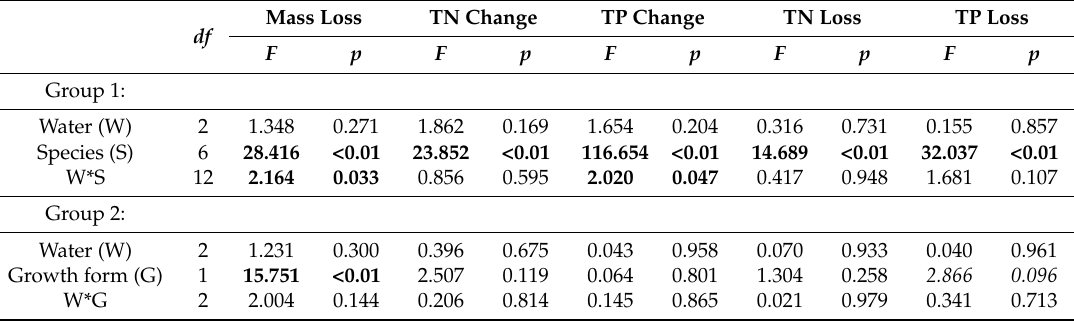
Table 1. ANOVAs for effects of water substrates (W) and plant species (S) or growth form (G) on the litter mass loss, the TN and TP changes, and the TN and TP losses, Values where p < 0.05 are in